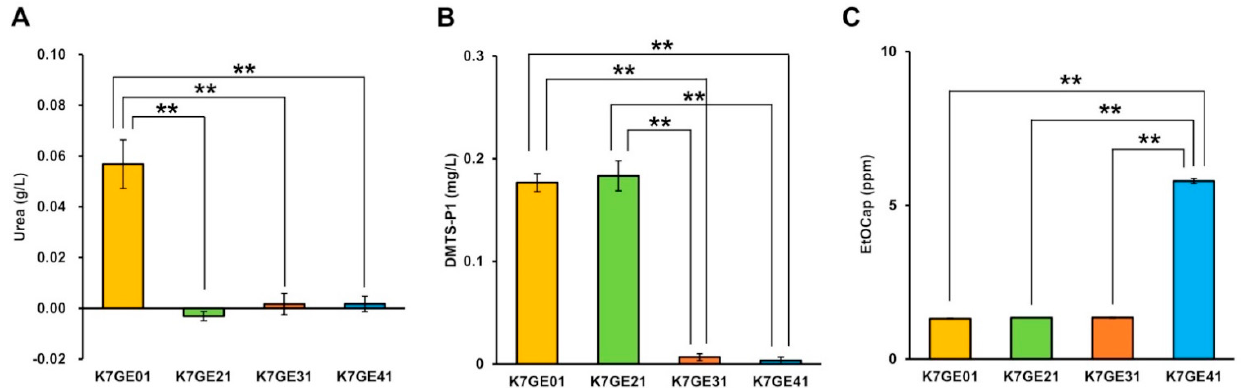
Figure 3. Measurement of urea ( A ), dimethyl trisulfide-P1 (DMTS − P1) ( B ) and ethyl caproate ( C ) in sake made with genome-edited strains. Error bars indicate standard error ( n = 3). Asterisks indicate Tukey’s multiple comparison test (** p < 0.01).